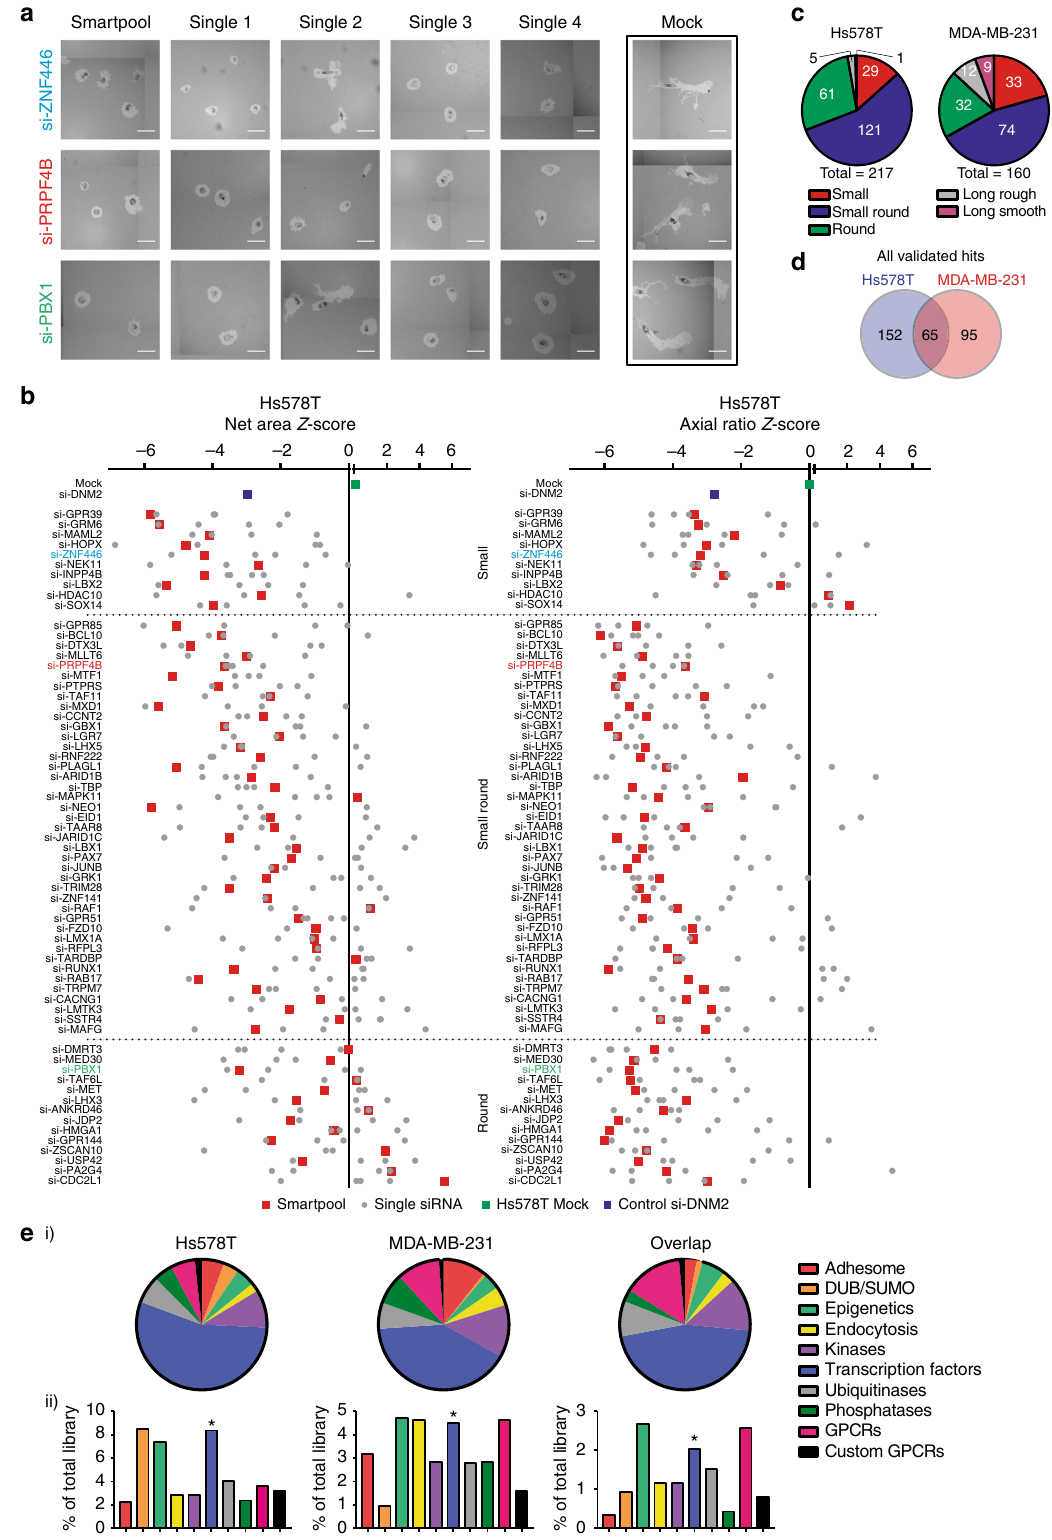
Fig. 2 Candidate migratory gene validation by deconvolution PKT screen. a Representative images of valid candidate genes using four individual single siRNAs in three phenotypic classes are shown. Scale bar is 100 µ m. b A total of 282 selected genes were tested in a deconvolution PKT screen with four single siRNAs per gene. SMARTpool and single siRNA Z-scores of Net Area and Axial Ratio are shown for the overlap hits that were validated in Hs578T. Average of biological and technical duplicates. c Distribution of validated candidate genes in the fi ve phenotypic classes. d Overlap of validated hits between Hs578T and MDA-MB-231. e Distribution of the validated genes involved in tumor cell migration in Hs578T, MDA-MB-231 over the different libraries based on validated hits effective in both cell lines. Statistical signi fi cance was determined using a Fisher ’ s exact test. * p <